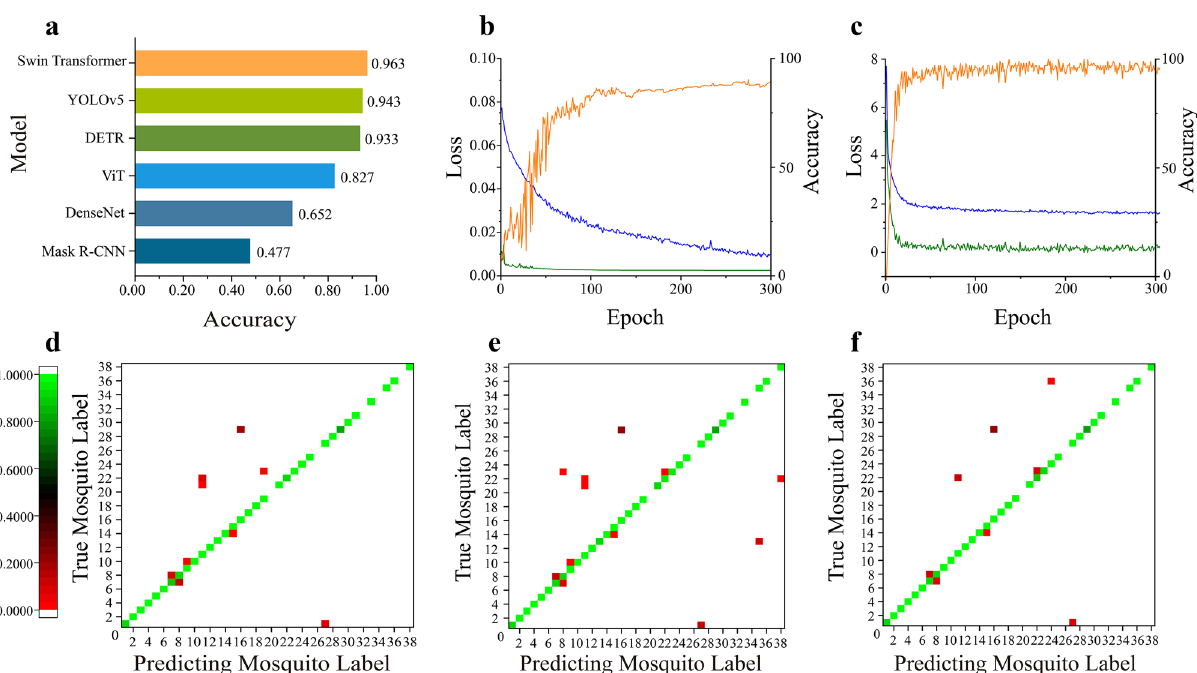
Figure 4. Comparison of mosquito recognition effects of computer vision network models and variants. ( a ) Comparison of mosquito identification accuracy between 3 CNNs and 3 Transformer; ( b ) The best effect CNN (YOLOv5) training set loss curve(blue), validation set loss curve(green) and validation set accuracy curve(orange); ( c ) The best effect Transformer (Swin Transformer) training set loss curve, validation set loss curve and validation set accuracy curve. ( d ) Swin-MSI-T test result confusion matrix; ( e ) Swin-MSI -B test result confusion matrix; ( f ) Swin-MSI -L test result confusion matrix. Confusion matrix of mosquito labels in which odd numbers represent females and even numbers represent males. The small squares in the confusion matrix represent the recognition readiness rate, from red to green, the recognition readiness rate is getting higher and higher An. sinensis : 1, 2; Cx. pipiens quinquefasciatus : 3, 4; Cx. pipiens pallens : 5, 6; Cx. pipiens molestus : 7,8 Cx. modestus : 9,10; Ae. albopictus : 11, 12 Ae. aegypti : 13, 14; Cx. pallidothorax : 15, 16 Ae. galloisi